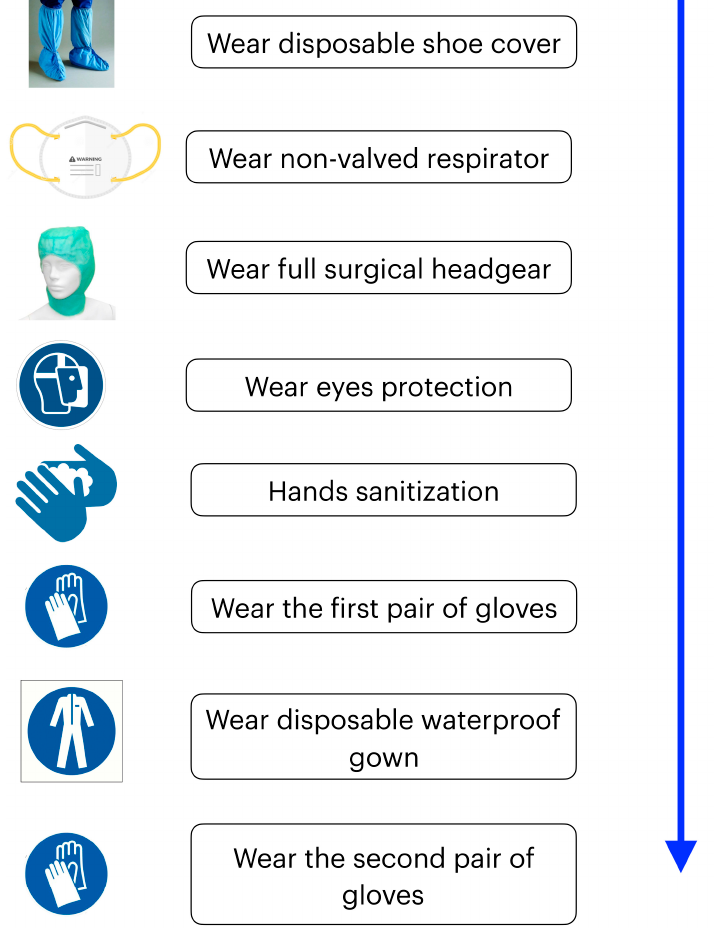
Figure 4. Operational sequence for putting on Personal Protective Equipment (PPE).